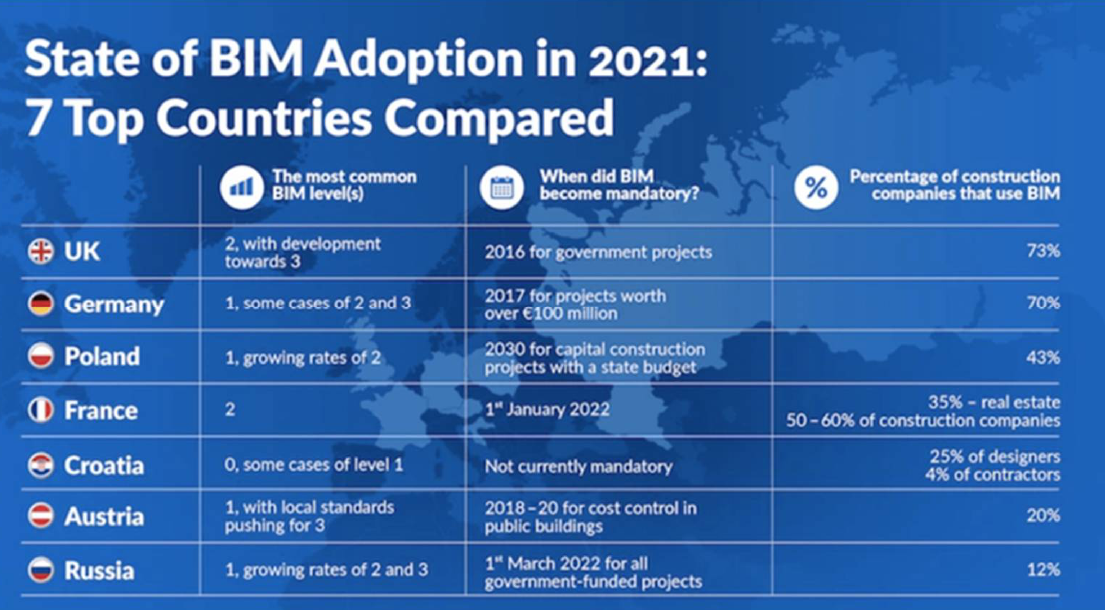
Figure 5. State of BIM adoption in 2021: top 7 countries compared.